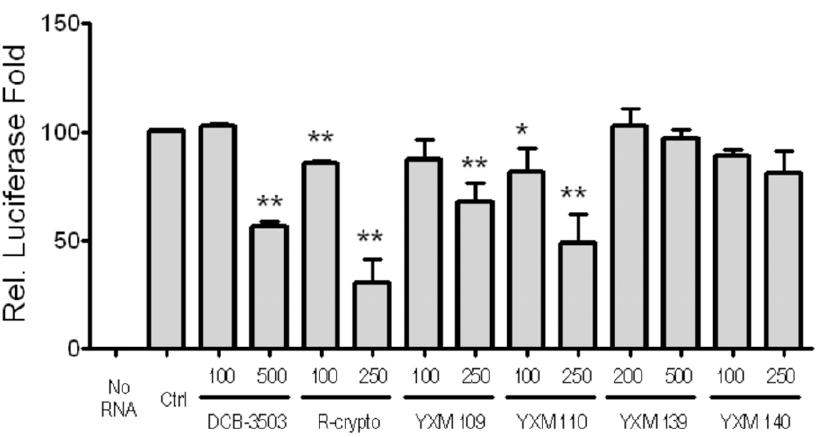
Figure 5. Cryptopleurine analogs inhibited luciferase translation in Retic lysate IVT system. Results were mean 6 SD from three independent experiments. (**, p , 0.01; *, p , 0.05).